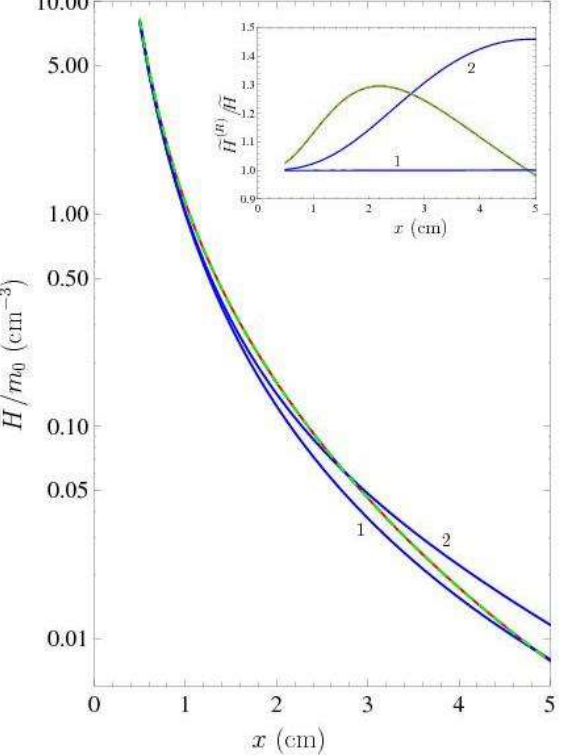
Figure 5. The normalized magnitude of total monochromatic magnetic field above the copper plate computed using the Drude model at the dipole height of 1 cm for the oscillation frequency of 0.2 and 100 rad/s as the function of separation from the magnetic dipole is shown by the solid lines 1 and 2, respectively. Another solid line overlapping with the dashed one shows the same quantity computed using the plasma and spatially nonlocal models. The inset shows the ratio of magnitudes of the reflected and total field computed using the Drude model (lines 1 and 2 for the dipole oscillation frequencies of 0.2 and 100 rad/s, respectively) and the plasma and spatially nonlocal models (the solid line overlapping with the dashed